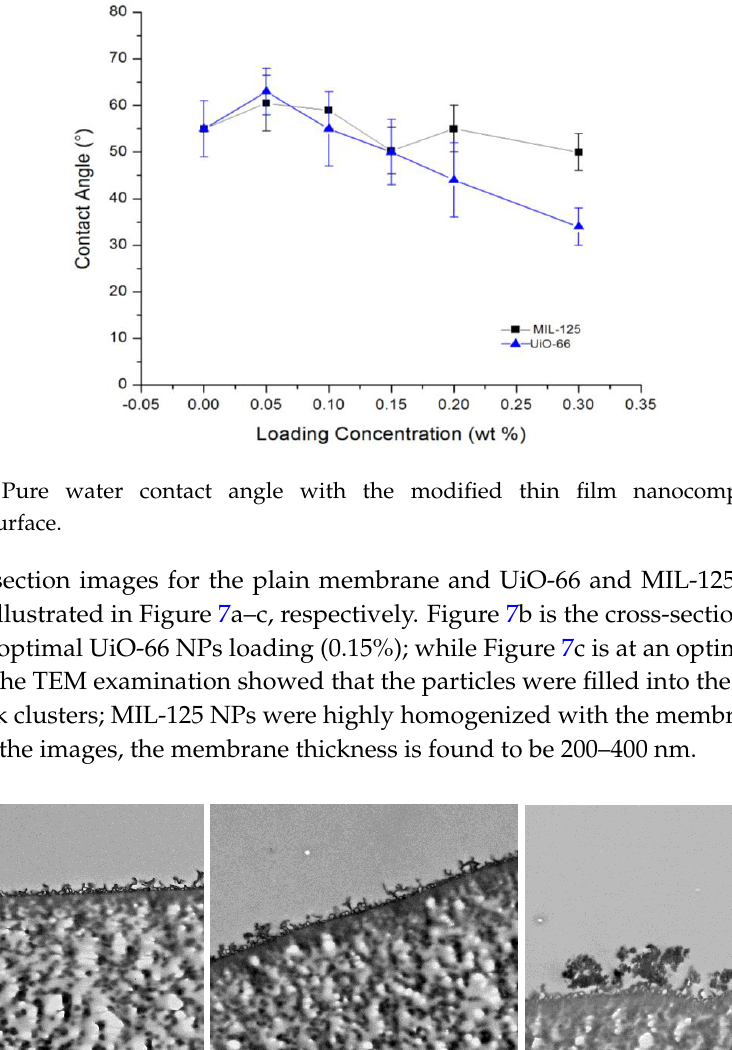
Figure 7. Transmission electron microscopy (TEM) images of ( a ) thin film composite (TFC) membrane, ( b ) TFN membrane of 0.15% UiO-66, and ( c ) TFN membrane of 0.3% MIL-125.